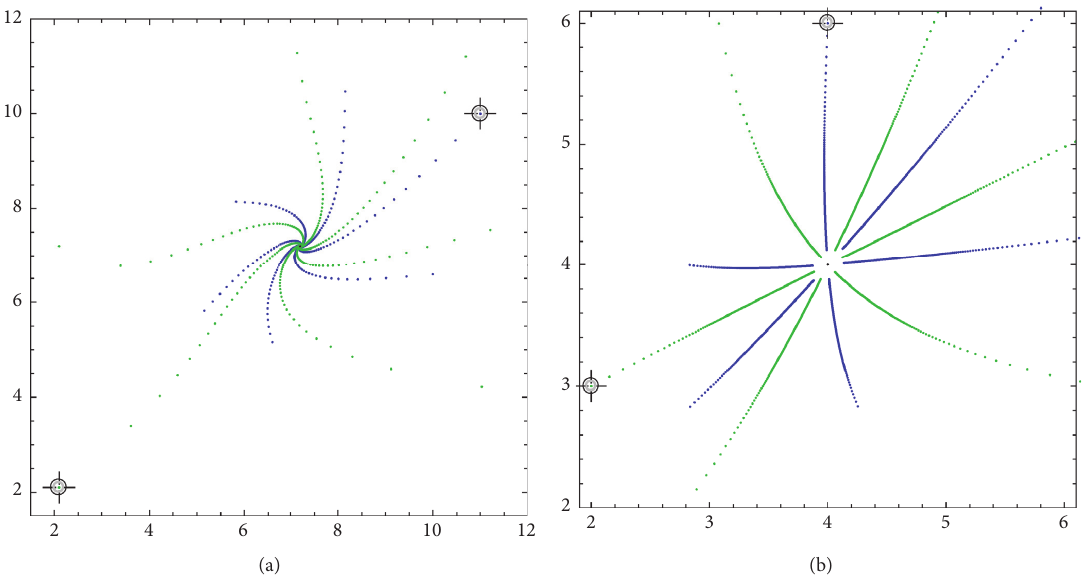
, x ) � ( 6 . 8 , 7 . 3 ) (b), for p � 2 . 9 and q � 3. − 1 0